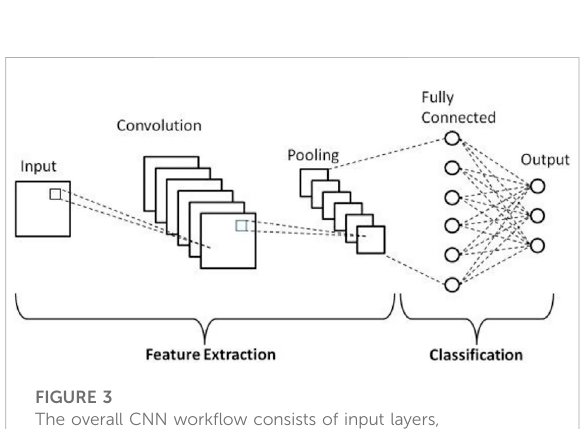
The overall CNN work fl ow consists of input layers, convolution layers, pooling layers, fully connected layers, and output